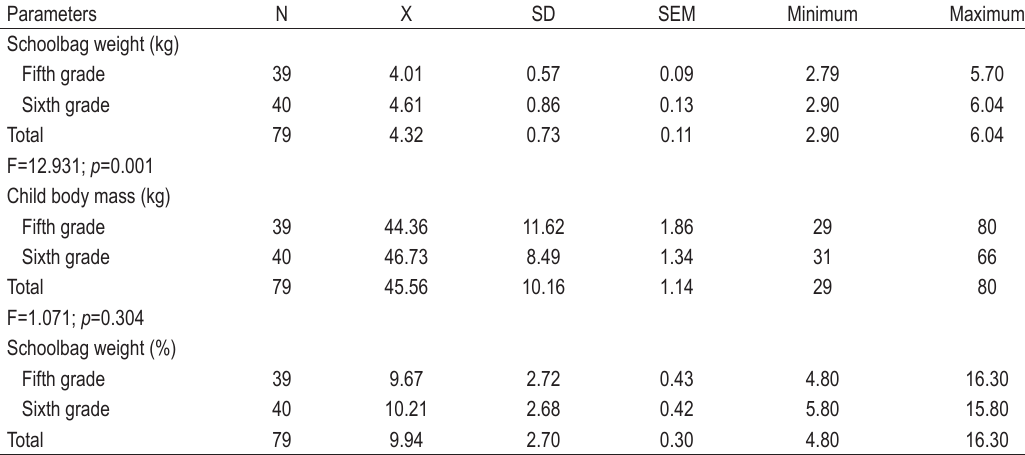
TABLE 6. Schoolbag weight (absolute and relative) in relation to the body mass of